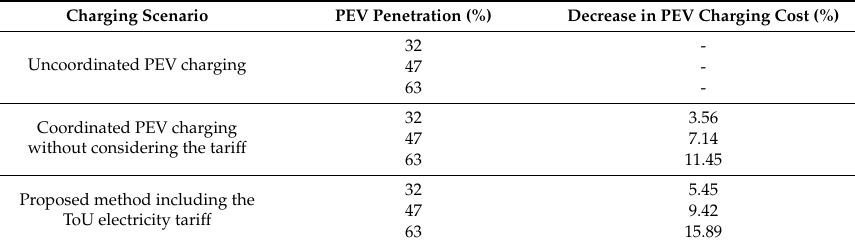
Table 4. PEV charging